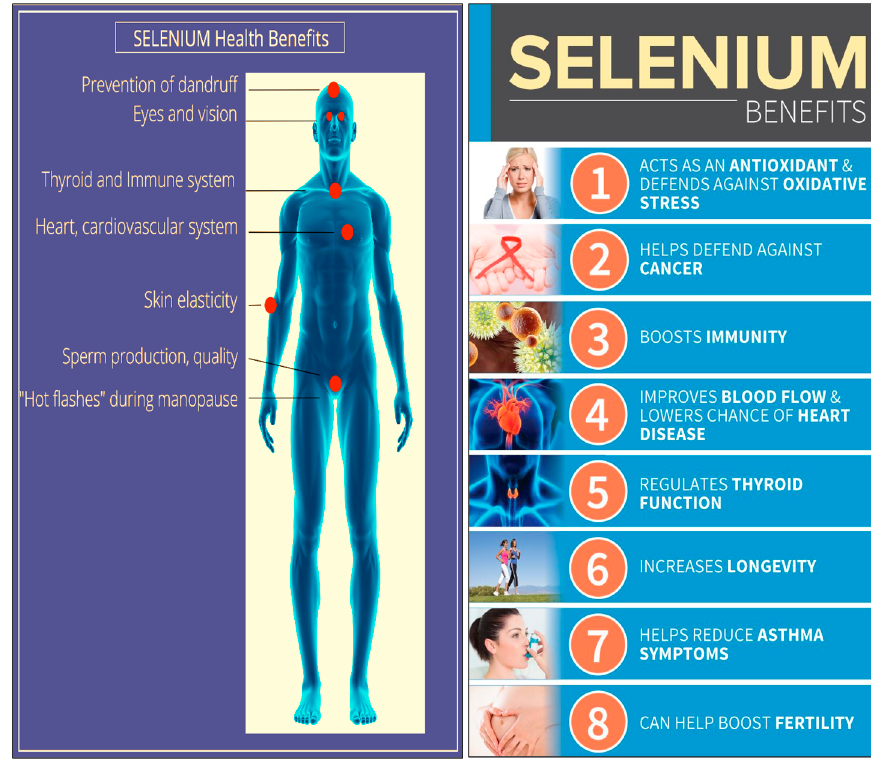
Figure 2. Health benefits of Se in the physiological processes of the human